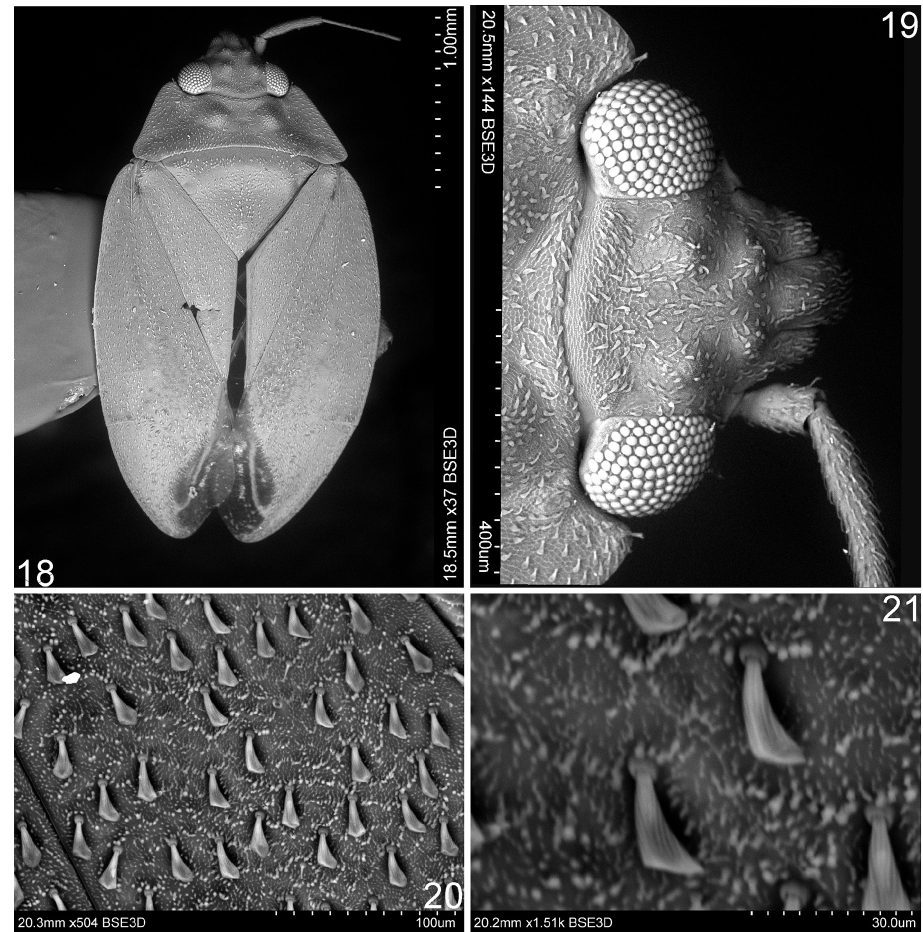
Figures 18–21. Scanning electron micrographs of Sulawesifulvius thailandicus (holotype) 18 Dorsal habitus 19 Head (dorsal view) 20–21 Structure and vestiture of